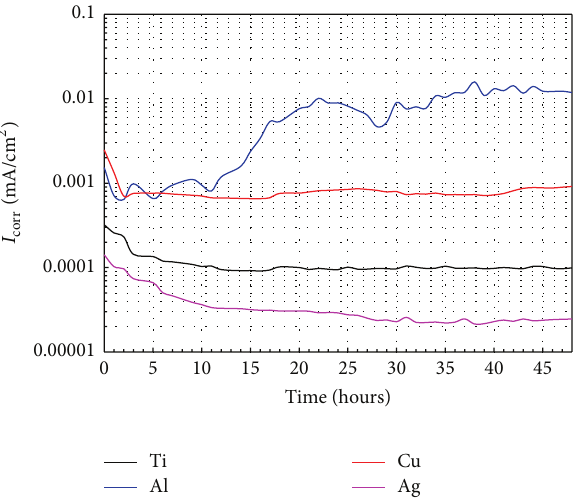
Figure 7: Change of 𝐼 corr values with time for the pure elements in artificial saliva at 37 ∘ C.